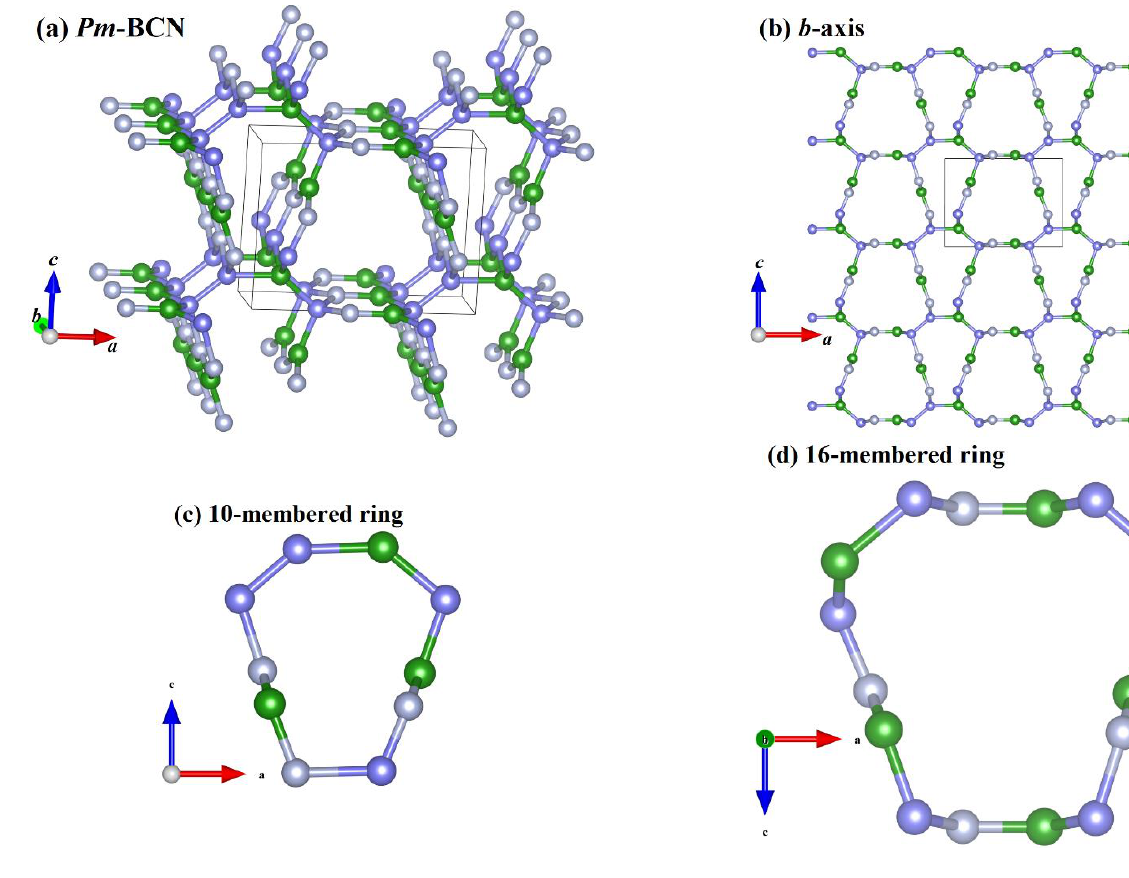
Figure 1. Crystal structures of Pm -BCN ( a ), Crystal structures of Pm -BCN along b -axis ( b ), the 10- membered ring structure ( c ), and the 16-membered ring structure ( d ). Table 1. Crystal lattice parameters of Pm BCN and other B-C-N compounds.